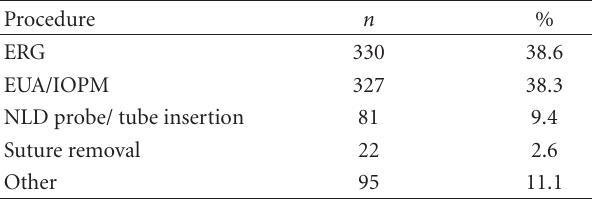
Table 7: Average reduction in hospital charges compared to the OR